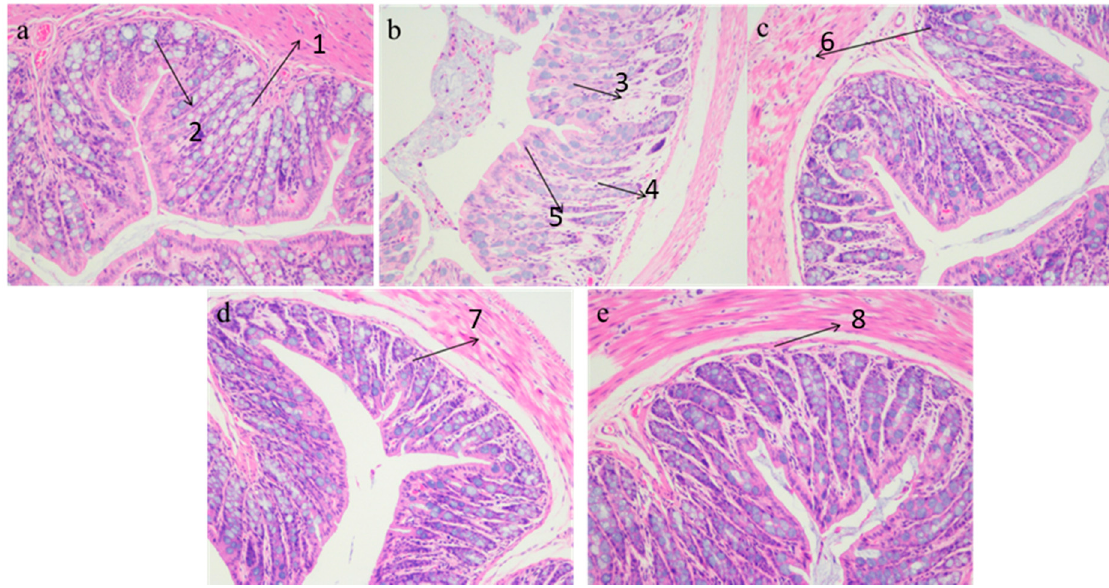
Figure 5. Effects of three cloudy apple juices on high-fat diet-induced histopathological alterations in the colon (200×). Note: ( a ): basal diet & Saline; ( b ): 45% high-fat diet & Saline; ( c ): 45% high-fat diet & CAJ; ( d ): 45% high-fat diet & CAJP; ( e ): 45% high-fat diet &FCAJP. Arrow 1: colonic mucosa structure were relatively complete; Arrow 2: the crypt structure were relatively complete; Arrow 3: the villi of the colon were broken and arranged in a disorderly manner, the crypt structure was damaged; Arrow 4: the epithelial mucosa of the colon was edema, and ulceration and shedding occurred in some parts; Arrow 5: villi and crypts of the colon were arranged irregularly, with obvious damage; Arrow 6–8: The colonic epithelial mucosa structure was slightly ulcerated, but the colonic villi and crypts were arranged in an orderly manner, with no obvious difference in inflammatory infiltration.